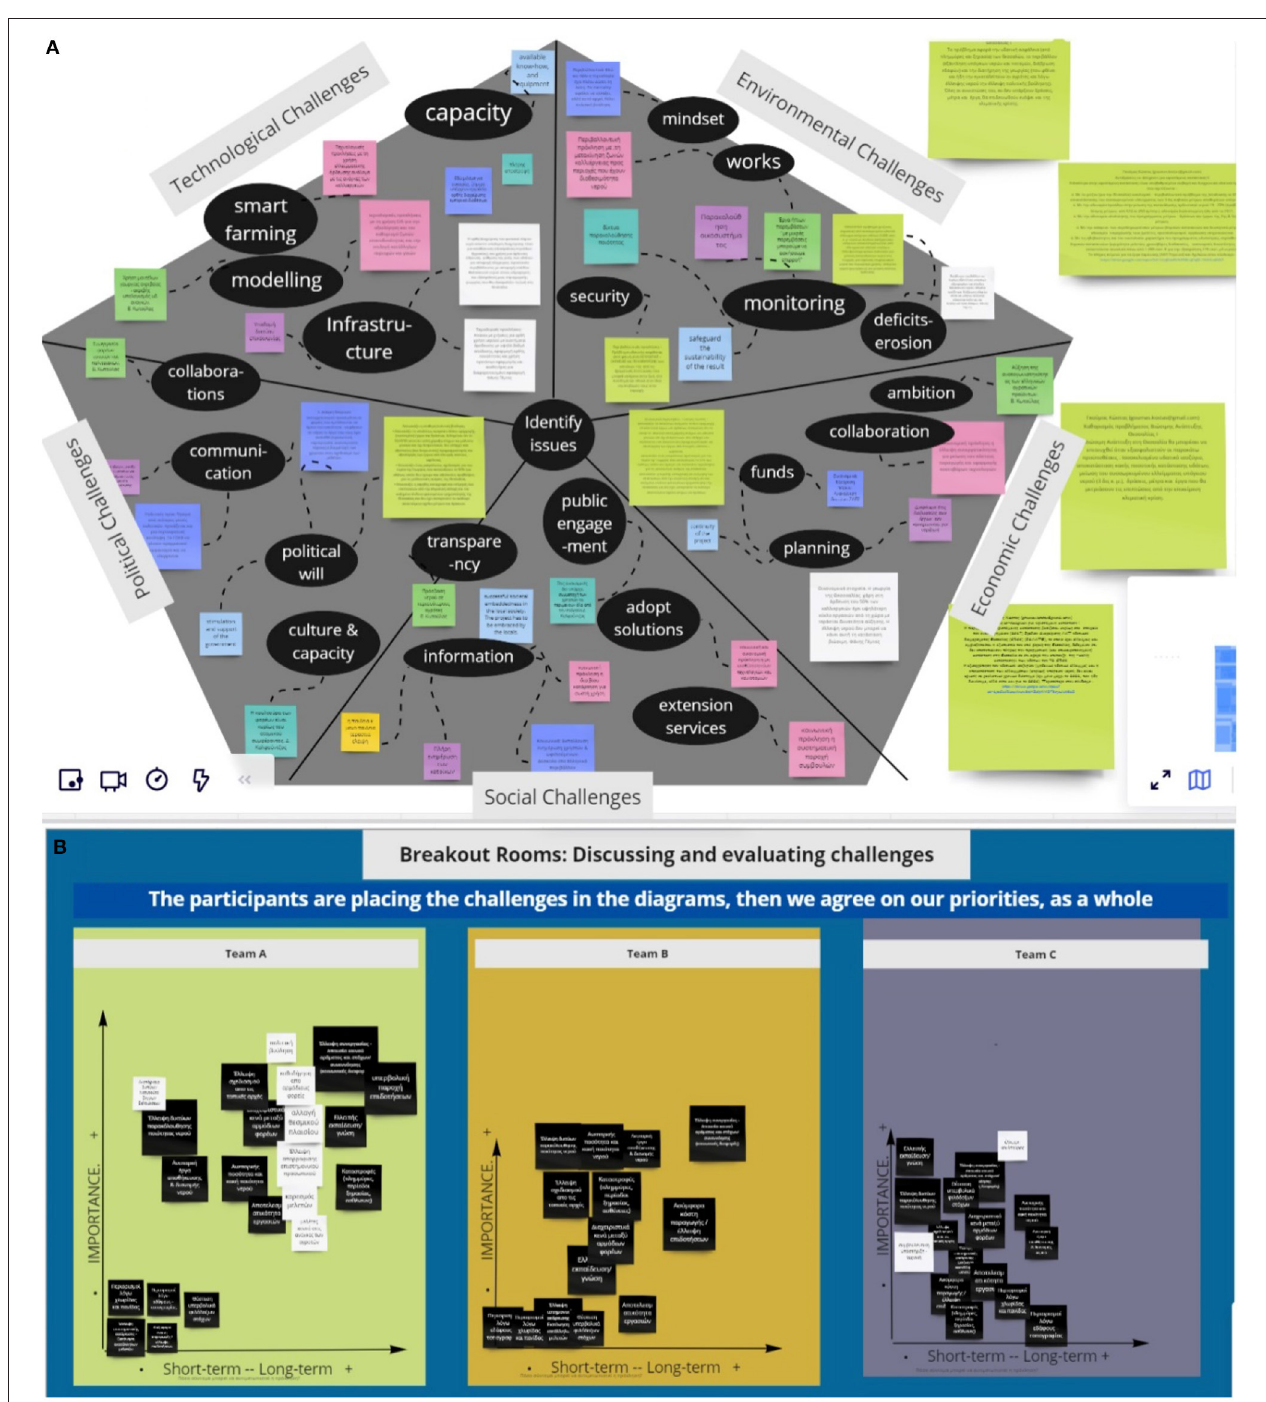
FIGURE 4 | (A) The Pentagonal problem. It is indicatively showing how the participants simultaneously described the: Environmental, Technological, Economic, Political and Social challenges they feel to face, by putting a note-description in the respective section of the pentagon. More explanatory notes can be added (sticky notes), as well as certain connections to indicate agreements and links between observations. (B) Importance—Timeframe matrix. This is indicatively showing how the participants evaluated the different challenges (black post-its) regarding their severity (y-axis) and the time-frame needed to address them (x-axis). Three break-out rooms were used, hence the three diagrams, and each participant posted a sticky note with a representative phrase indicating how important or not is to address a specific problem in the short or long-term. The stakeholders’ comments are in Greek, as the exercises were elaborated in Greek, but are indicative, only to show two examples of the various exercises of parallel actions carried out in MIRO together with the discussions.